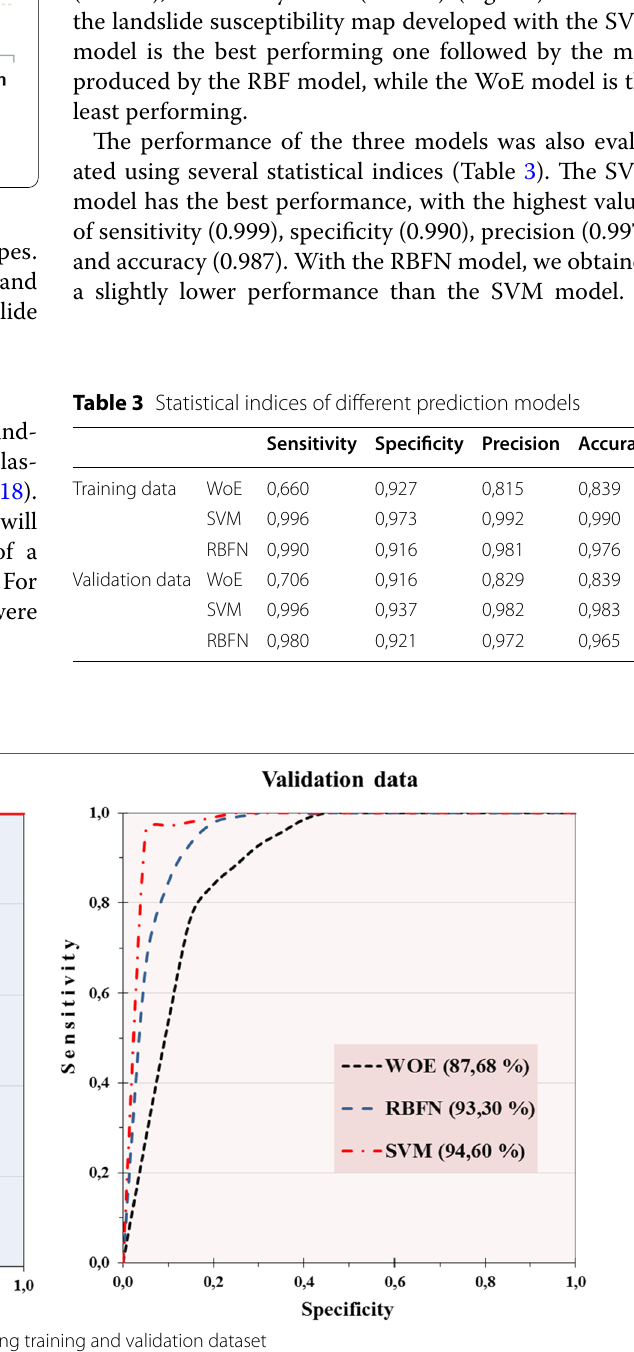
Fig. 10 Analysis of the ROC curve of different landslide models using training and validation dataset